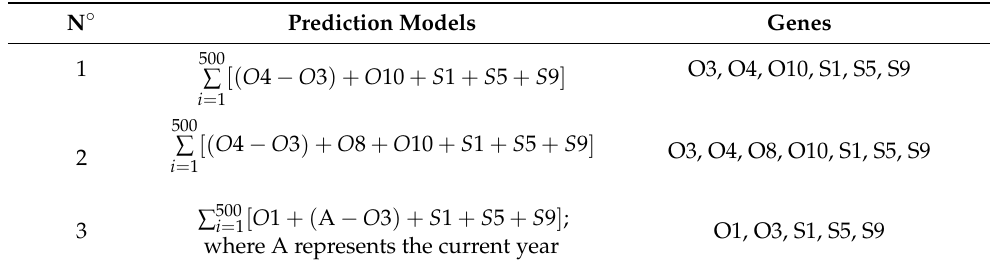
Table 7. Career success prediction